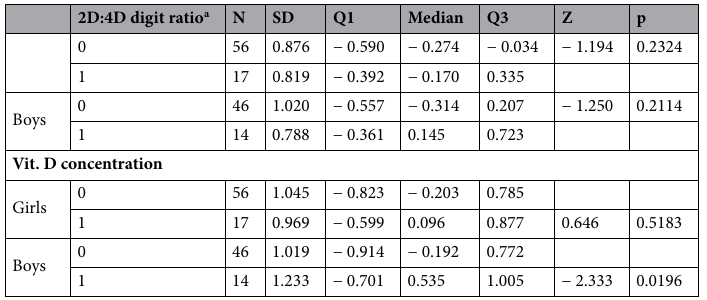
Table 1. The 2D:4D digit ratio pattern, cortisol and vitamin D concentrations in boys and girls. a 0: 2D:4D < 1; 1: 2D:4D ≥